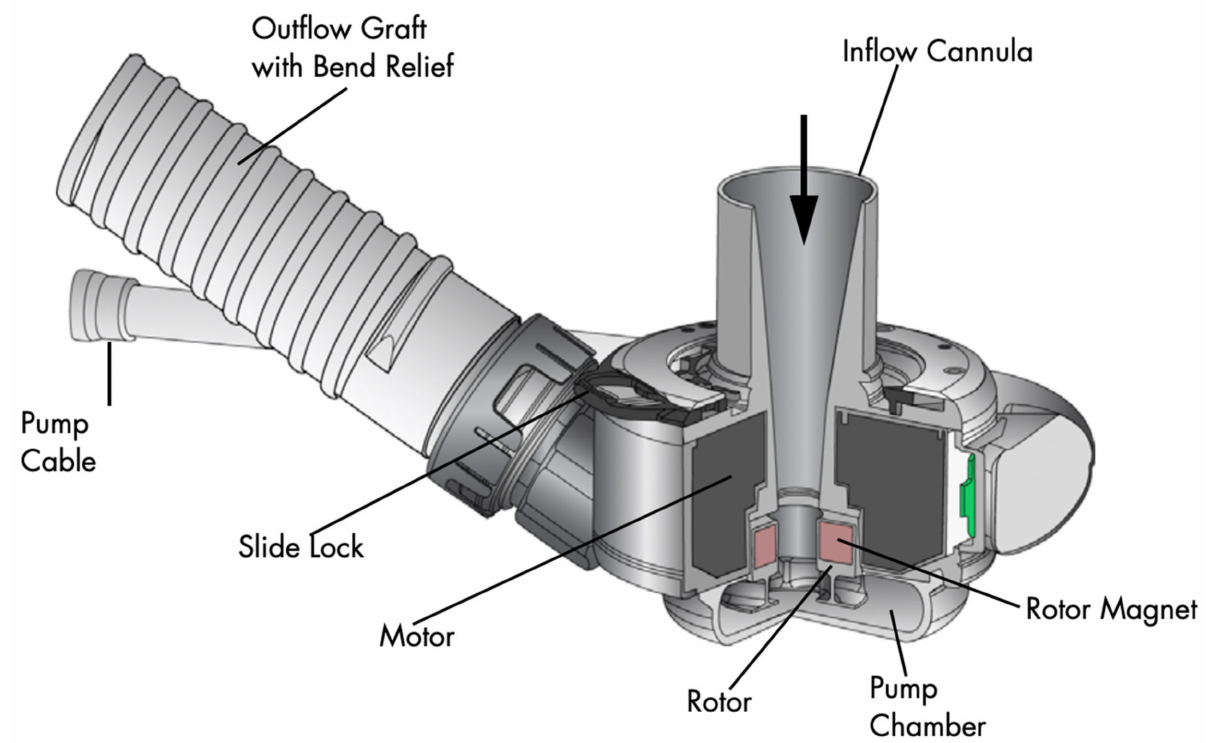
Figure 2. Device mechanics, detail. A HeartMate 3 left ventricular assist device (LVAD) shown with device mechanics. The inflow cannula is implanted into the left ventricular apex with the opening directed toward the mitral valve. Blood is circulated through the pump chamber via a spinning, magnetically levitated rotor which nominally operates at 5000–6000 rpm. Centrifugal effect forces the blood into the outflow graft, which meets the ascending aorta at a surgical anastomosis. (Image reprinted with permission from Abbott